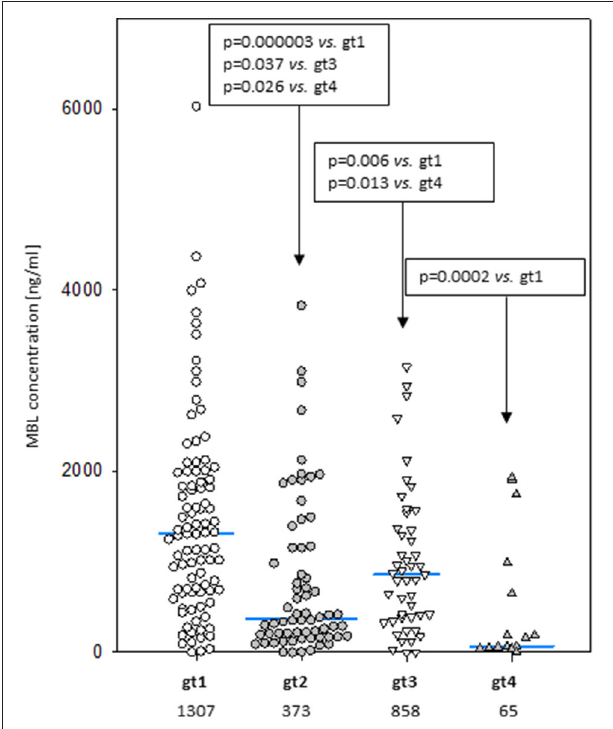
FIGURE 2 | Mannose-binding lectin serum concentrations in healthy controls carrying most common 3 ′ -UTR MBL2 genotypes (gt1-gt4; details are given in Table 3 ). Blue bars present median values (given below group descriptions).